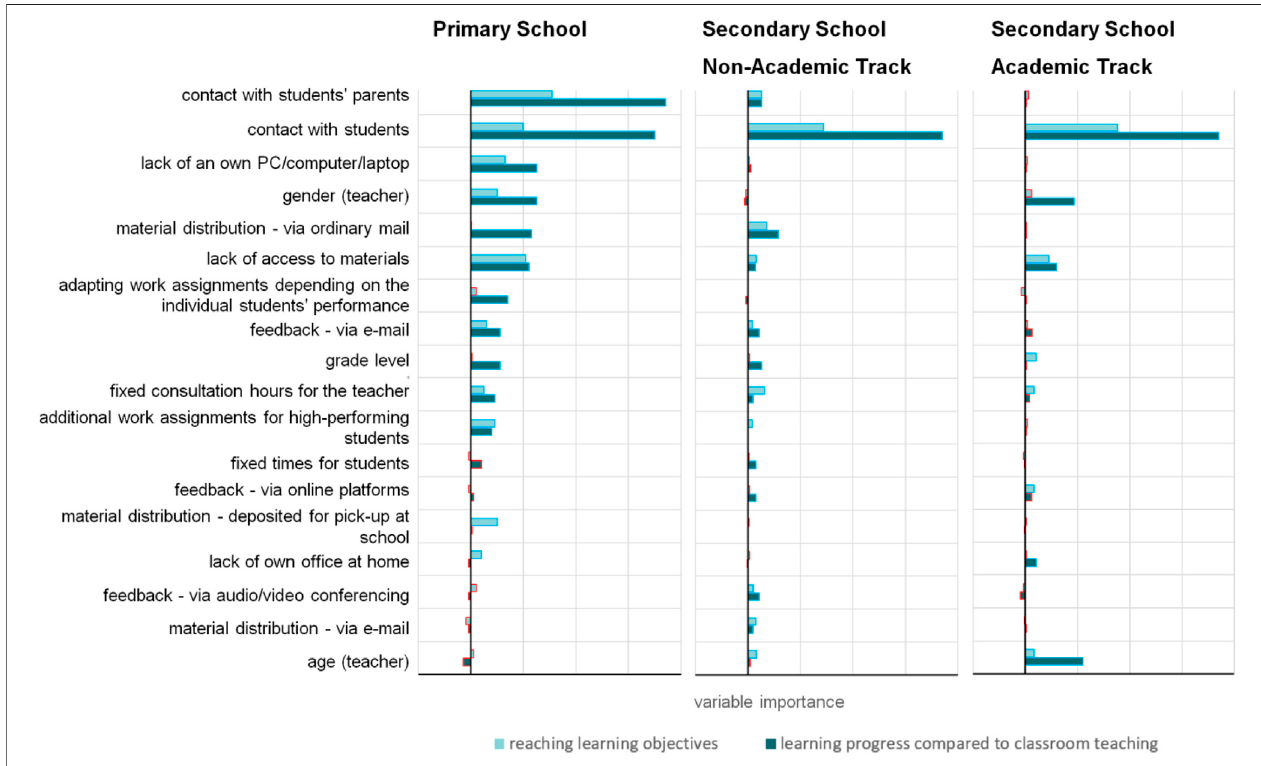
FIGURE 9 | Relative importance of predictor variables for explaining teacher-reported attainment of learning objectives as well as teacher-reported learning progress in comparison to classroom learning. Note . Variables that are bordered in red are not discussed in the text.